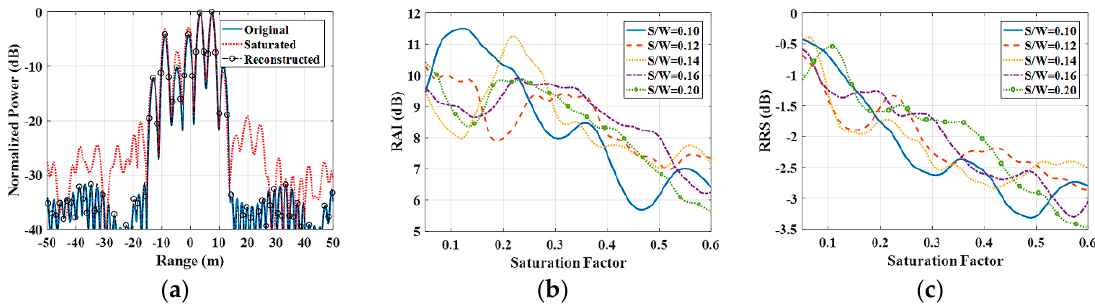
Figure 14. Performance of the proposed method. The ratio of the intensity of strong targets to that of the background is approximately 30 dB. ( a ) Pulse compression results with a Hamming window and a 30% saturation factor for the raw data. ( b ) RAIs for different saturation factors and S/W ratios. (c) RRSs for different saturation factors and S/W ratios. RAI stands for Radiometric Accuracy Improvement. S/W stands for the ratio of the Strong target quantity to the Weak target quantity. RRS stands for Relative value of Reduced Saturation.